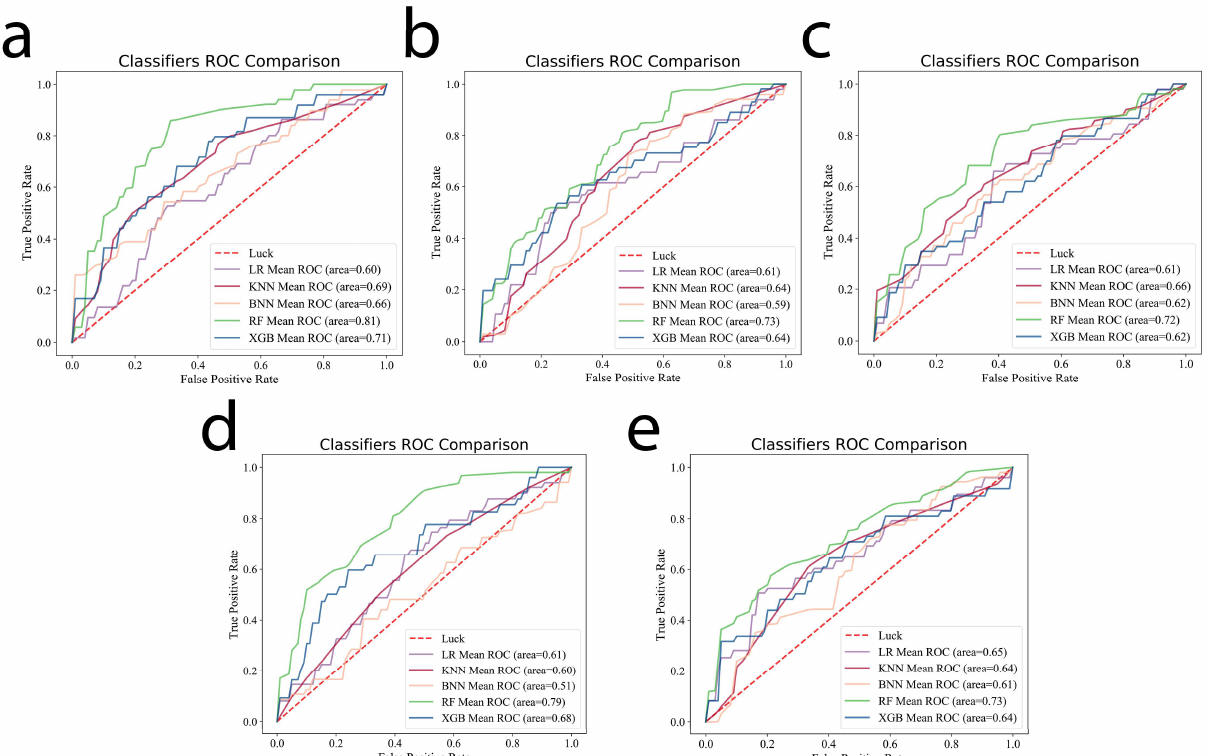
Figure 2. Five existing mainstream algorithms (Logistic Regression, kNN, Naive Bayes, Random Forest, and XGB Classifier) were chosen for the training and validation, which showed that AUC values obtained using the RF method are the highest among all of the models of different sequence combinations: ( a ) DWI + ADC; ( b ) T2WI + CE-T1WI; ( c ) DWI + ADC + T2WI; ( d ) DWI + ADC + CE-T1WI; ( e ) DWI + ADC + T2WI + CE-T1WI.